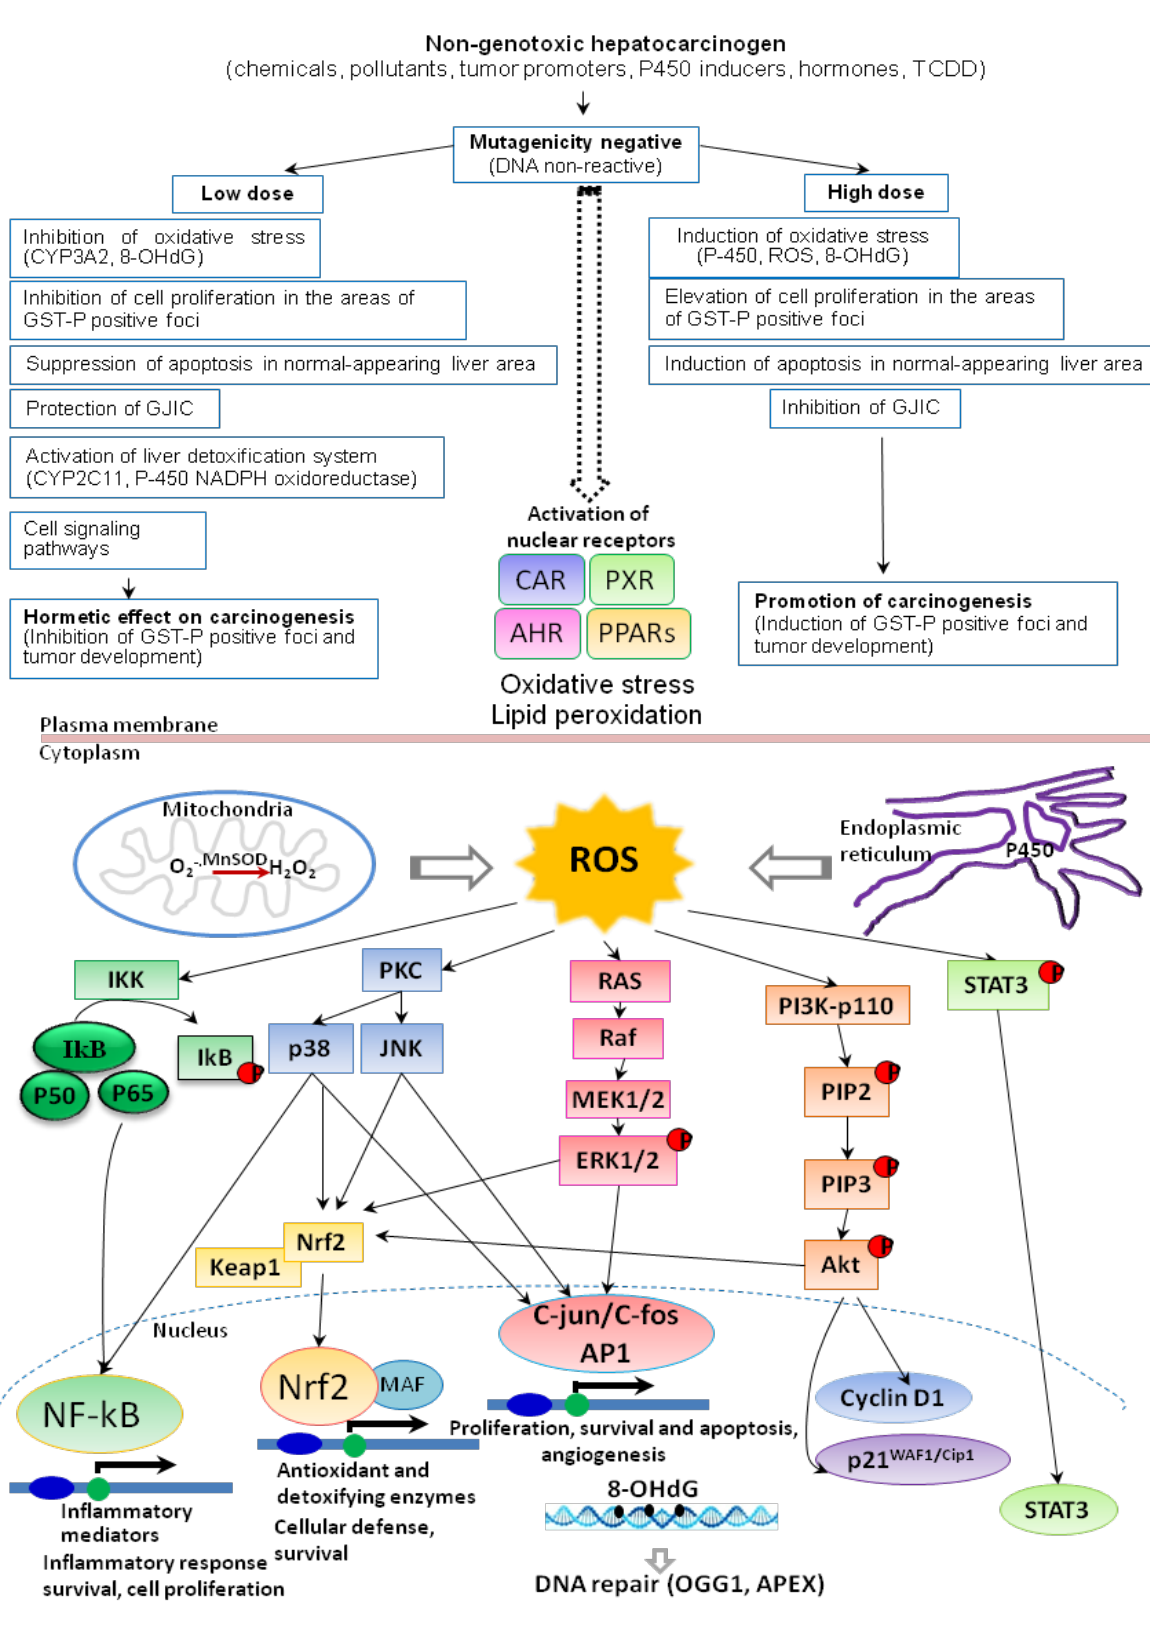
Figure 6. Flow scheme toward dose-effect relations and mechanisms of action of non-genotoxic chemical